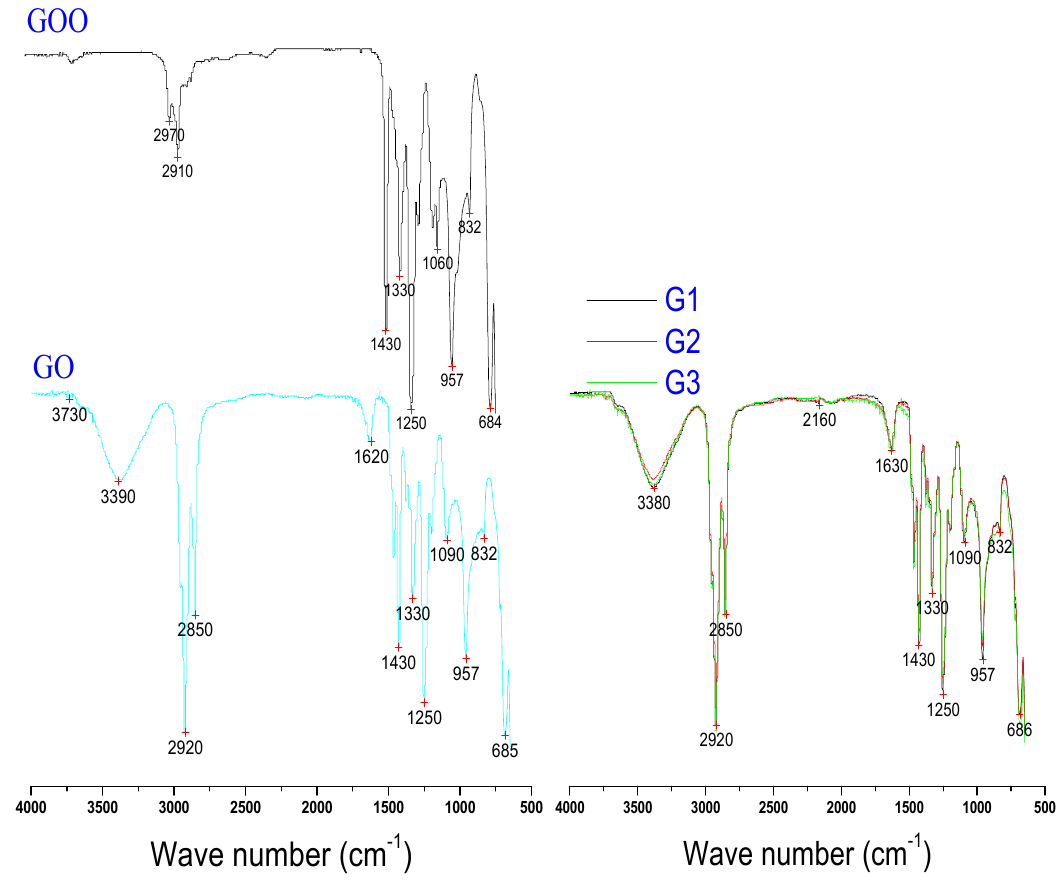
Figure 3. FTIR spectra of PIMs and their identical aligned constituents.